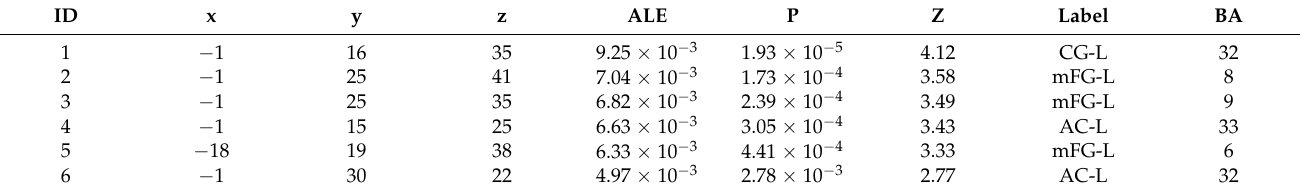
Table 1. ALE analysis